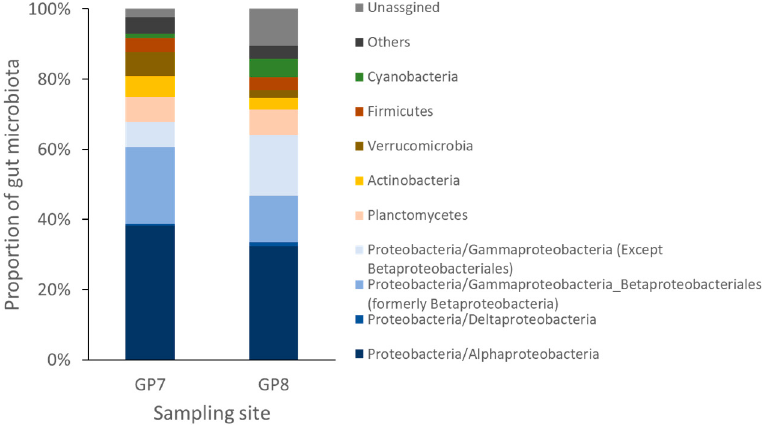
Figure 3. Bacterial diversity of gut microbiota 16S rRNA from blackworm Lumbriculus variegatus collected from two different sampling sites.